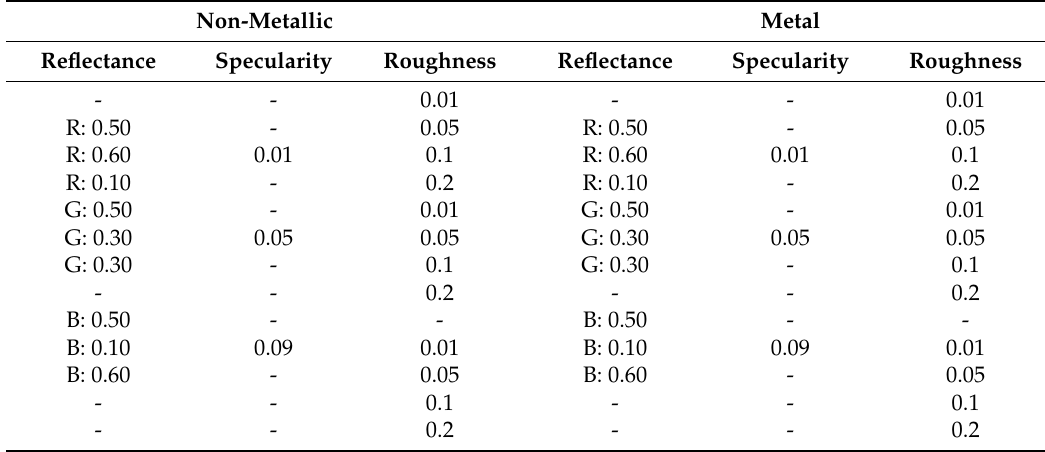
Table 1. Studied wall optical properties.